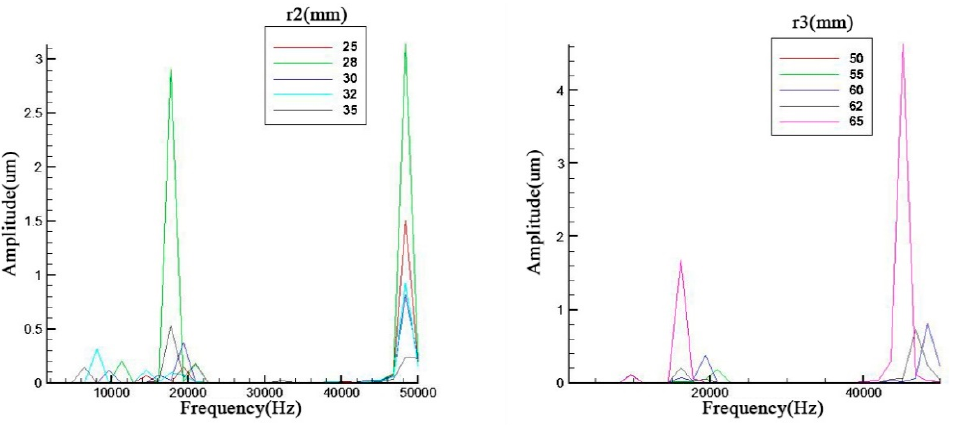
Figure 5. Parameter analysis of t 2 and t 3.